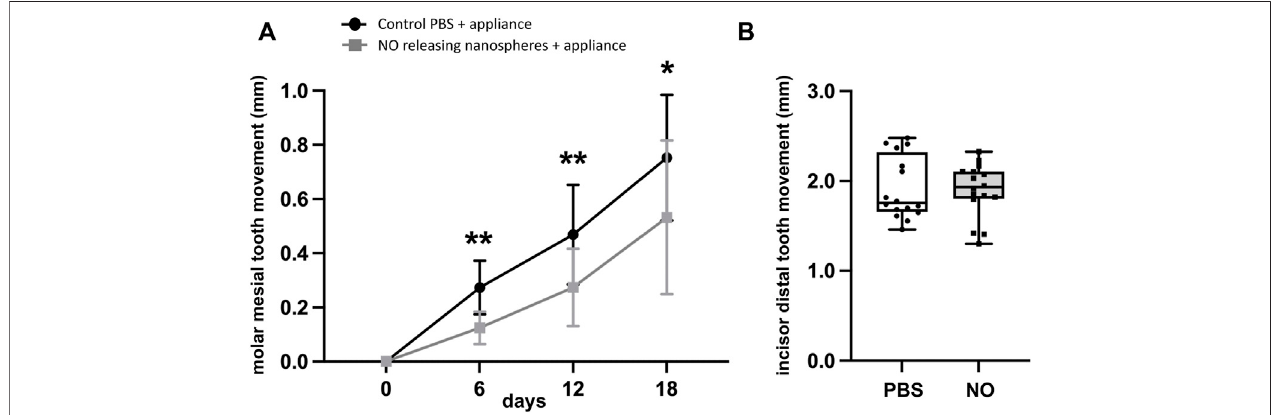
FIGURE 5 | Histology of the distobuccal root after 18 days ± orthodontic tooth movement. Hematoxylin and eosin (H&E) stained representative images of the distobuccal root of the fi rst molar of (A) animals that received control saline injections and no orthodontic appliances, (B) animals that received control saline injections and had orthodontic appliances, (C) animals that received experimental nanoparticles injections and no orthodontic appliances, and (D) animals that received experimental nanoparticles injections and had orthodontic appliances. OTM = orthodontic tooth movement, saline = PBS = phosphate buffered saline.